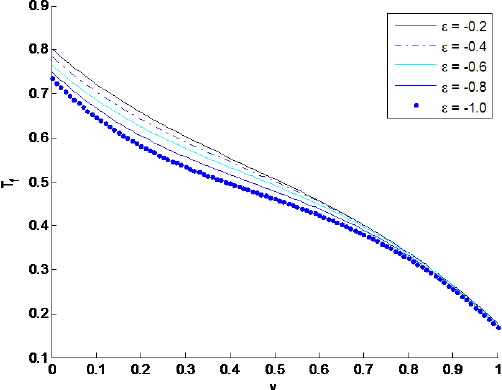
Figure 10: Velocity profile for different values of variable thermal conductivity ε ( Br = 0.2 , S = 0.4 , Gre = 10 , λ = −0.3 , d = 0.2 , q = 1 )